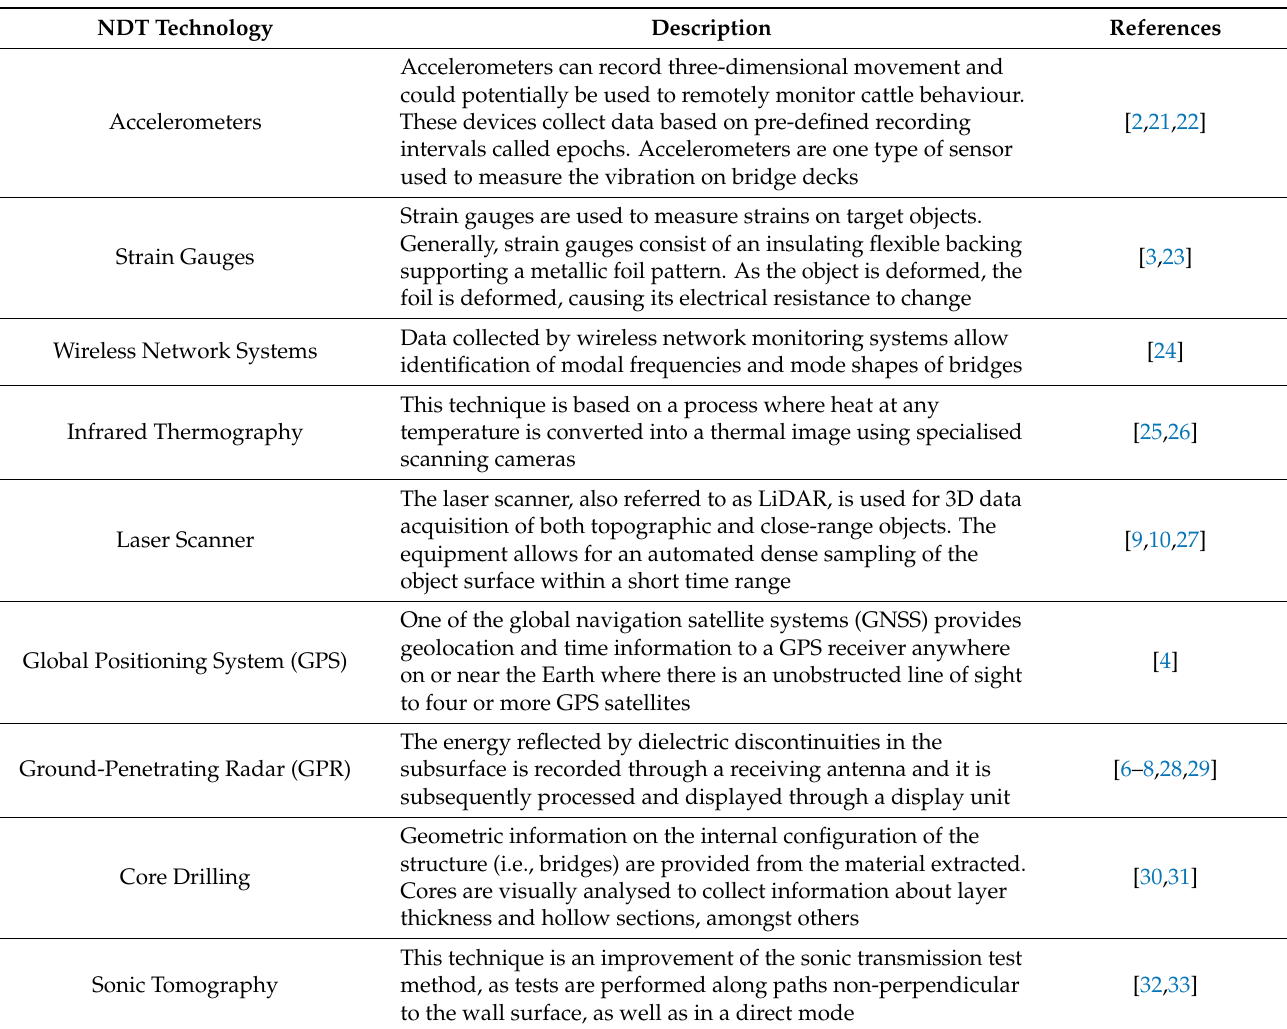
Table 1. Non-destructive testing (NDT) methods and sensors used in transport infrastructure